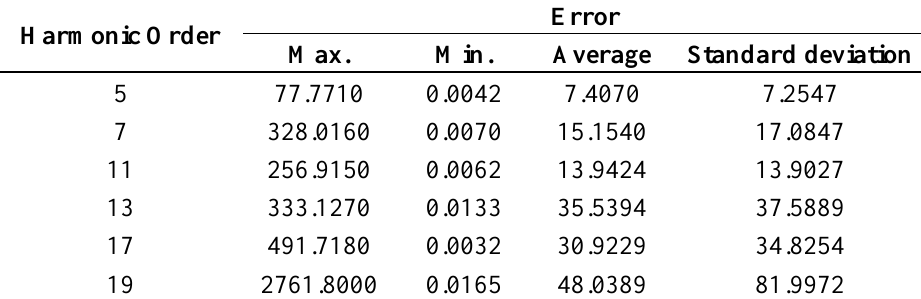
Table 3. Prediction results of ARMA